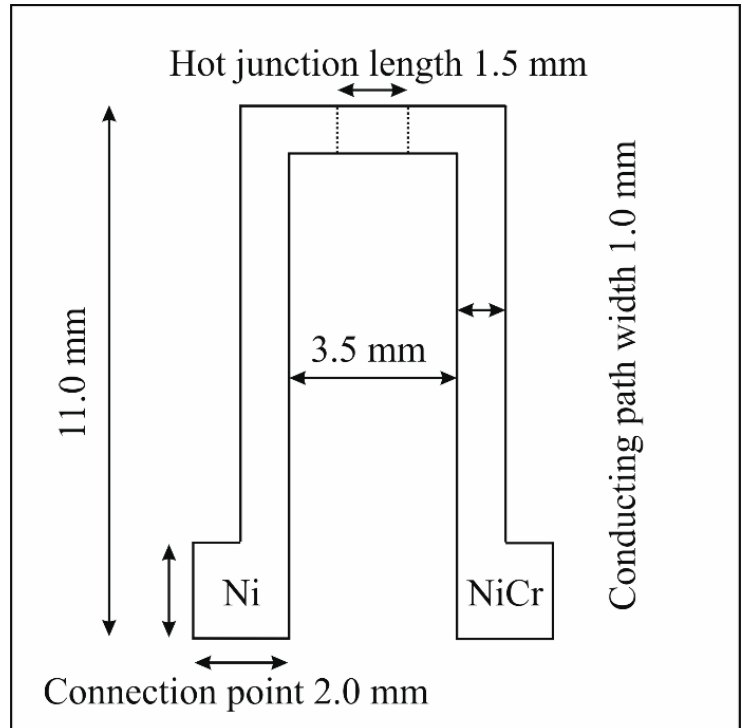
Figure 2. Drawing of the design of the thin film thermocouples with corresponding sizes.